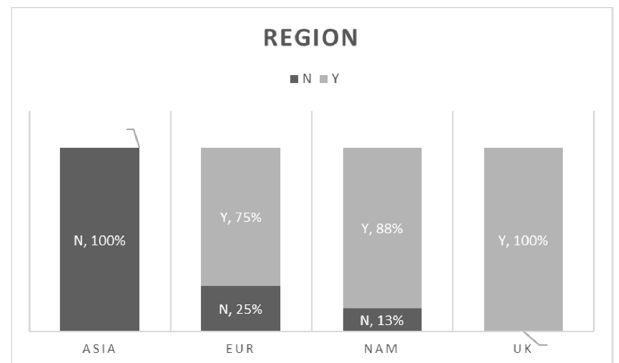
Figure 1. For each region, the percentage of banks (shown as ‘Y’) that have mentioned operational resilience in the annual report.